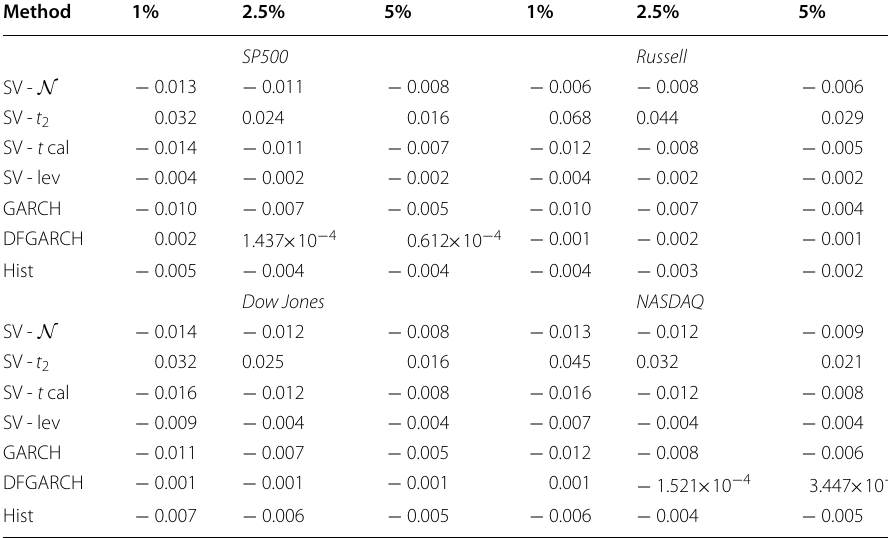
Table 2 Backtesting results based on